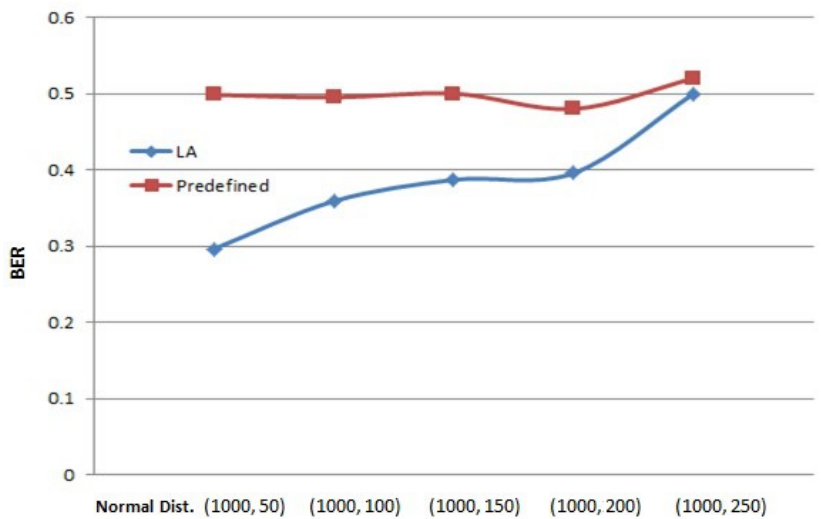
Figure 8. BER for the proposed solution versus a fixed threshold algorithm. The normal distribution refers to the number of bacteria per